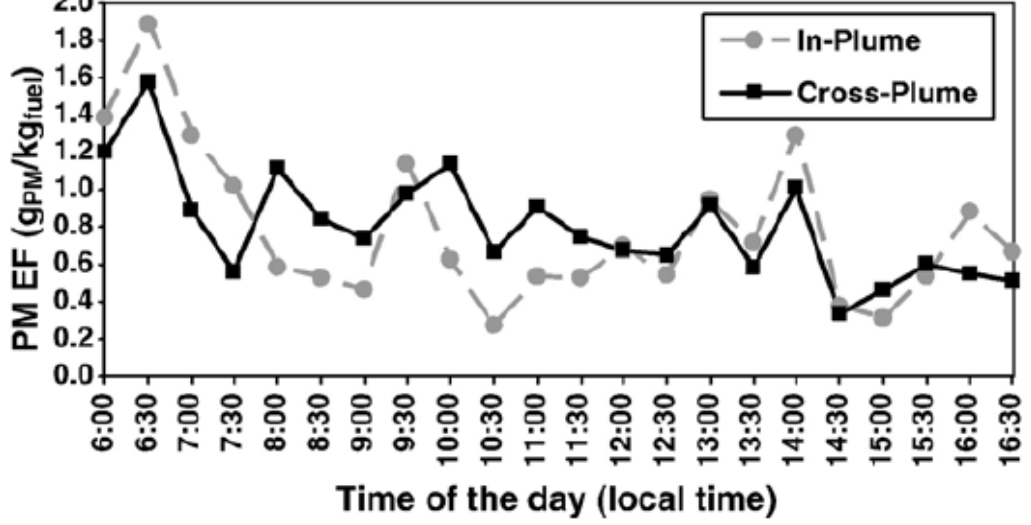
Figure 7. Time series for in-plume and VERSS systems for half-hour averaged PM EFs for the 4 th of March 2004. Overall average PM EFs are 0.78 ± 0.09 gPM/kgFuel and 0.80 ± 0.06 gPM/kgFuel for VERSS and in-plume system, respectively